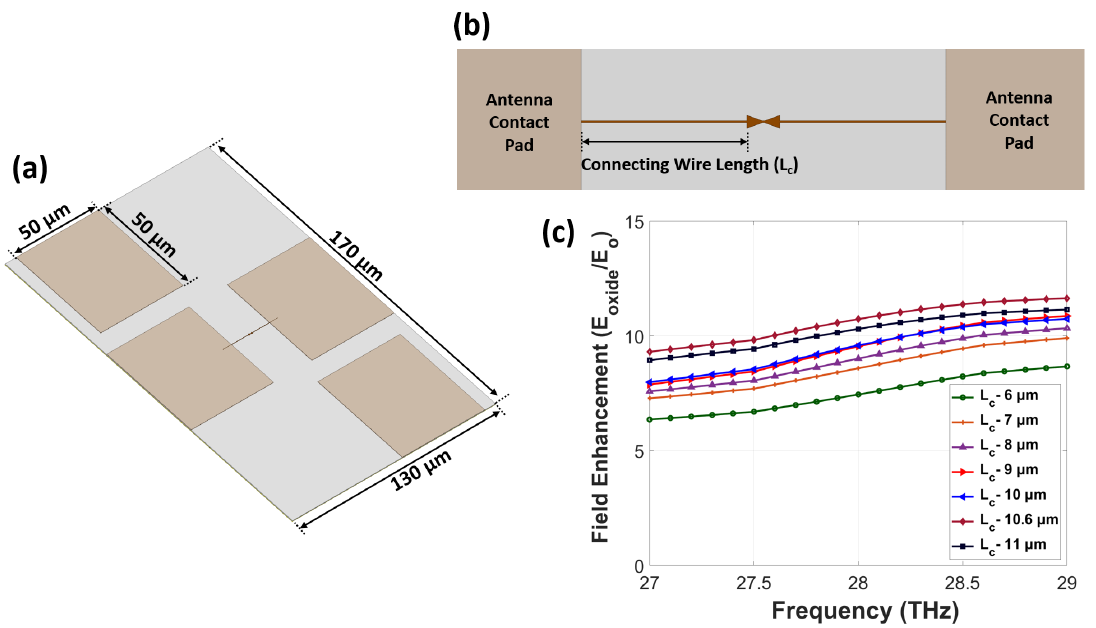
Figure 3. ( a ) The geometry of a nanoantenna-coupled p-doped MOS diode device with measurement pads. ( b ) The bowtie-shaped nanoantenna connected with the measurement pads through connecting metallic wires. ( c ) The frequency-dependent field enhancement versus length of the connecting wire (L c